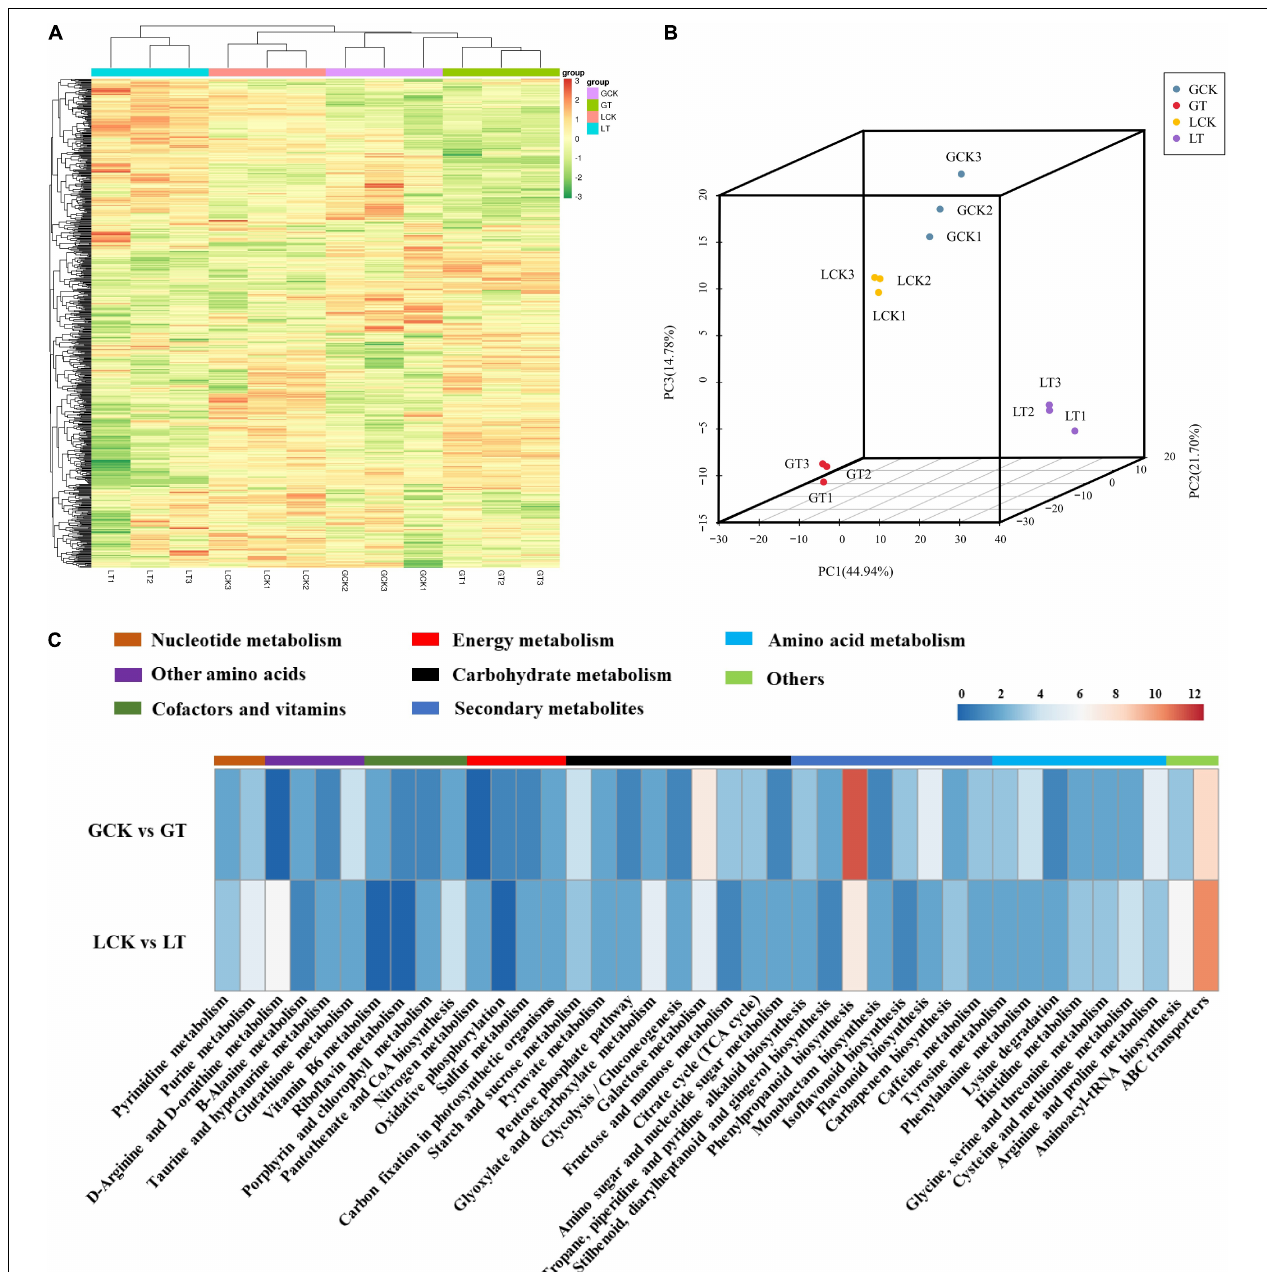
FIGURE 3 | Metabolite analysis using the leaves of resistant/sensitive millet varieties under atrazine stress. (A) Heat map visualization of metabolites. Each metabolite is represented by a single row and each example is visualized in a single column; red indicates upregulation and green indicates downregulation. (B) PCA of metabolites. PC1, the first principal component; PC2, the second principal component; PC3, the third principal component. (C) Distribution of pathways of DEMs annotated in the KEGG data library of resistant/sensitive (GA2/LG31) millet